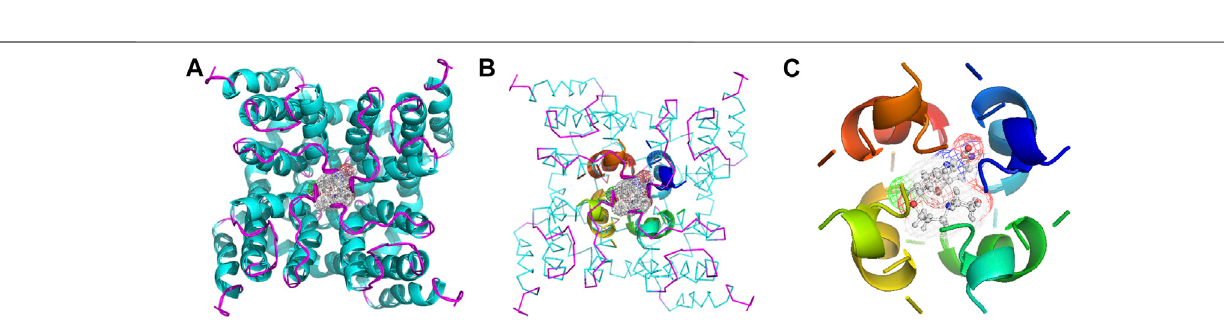
Frontiers in Molecular Biosciences |